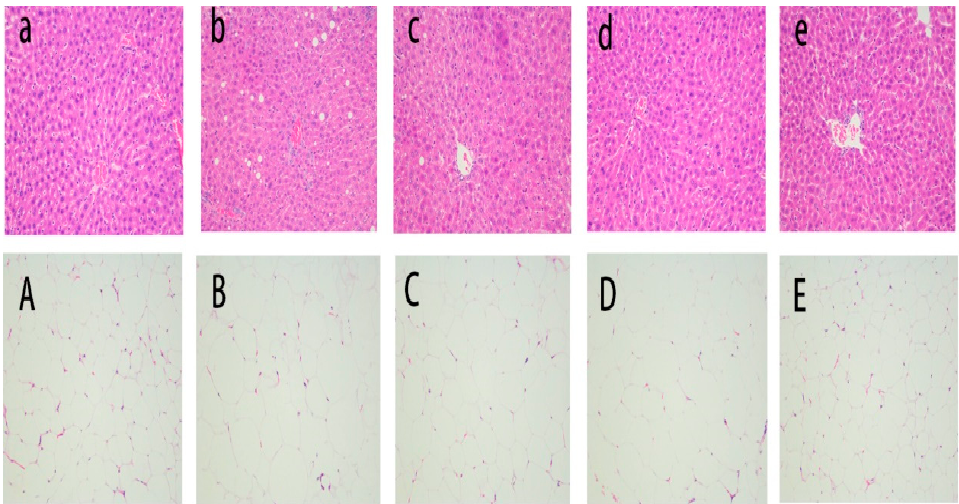
Figure 2. Effects of three cloudy apple juices on high-fat diet-induced histopathological alterations in the liver ( a – e ) and epididymal white adipose tissue ( A – E ) structure after H & E staining (200 × ). Note: ( A , a ): basal diet & Saline; ( B , b ): 45% high-fat diet & Saline; ( C , c ): 45% high-fat diet &CAJ; ( D , d ): 45% high-fat diet & CAJP; ( E , e ): 45% high-fat diet & FCAJP.